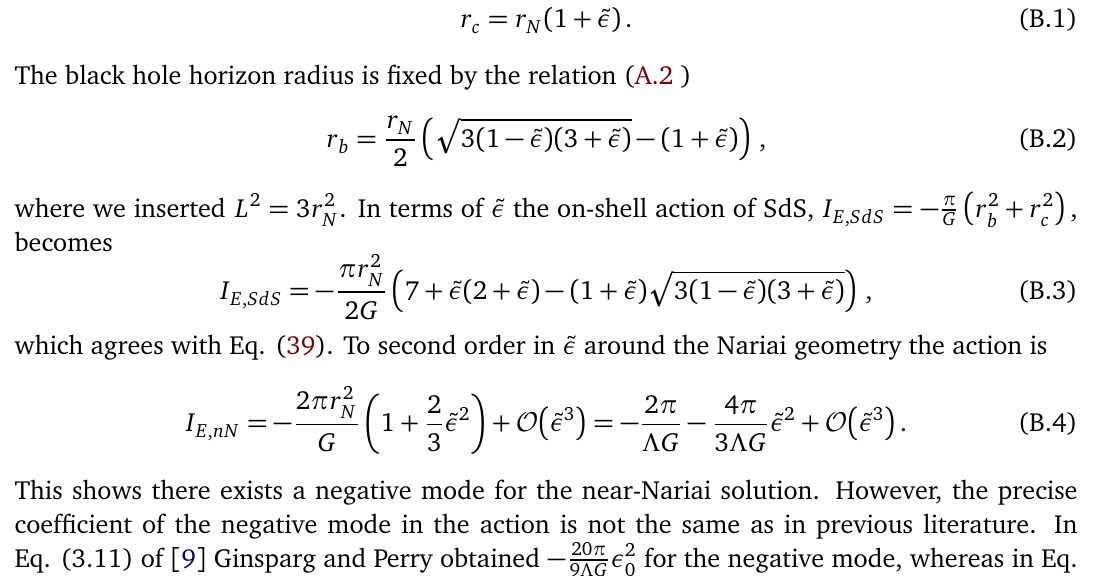
as a function of ε for d = dS